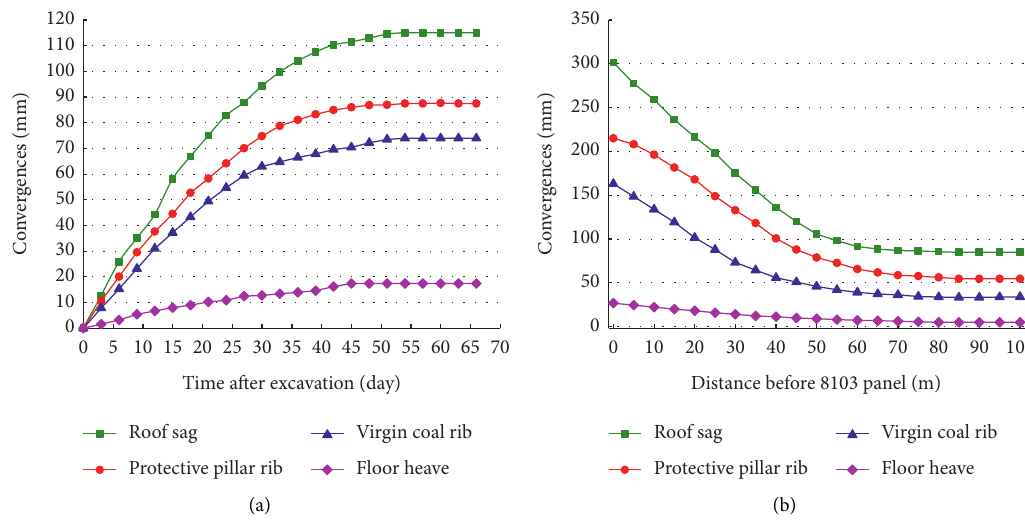
Figure 21: Measured convergences in 8103 headgate. (a) During 8103 headgate excavation. (b) During panel 8103 retreat.